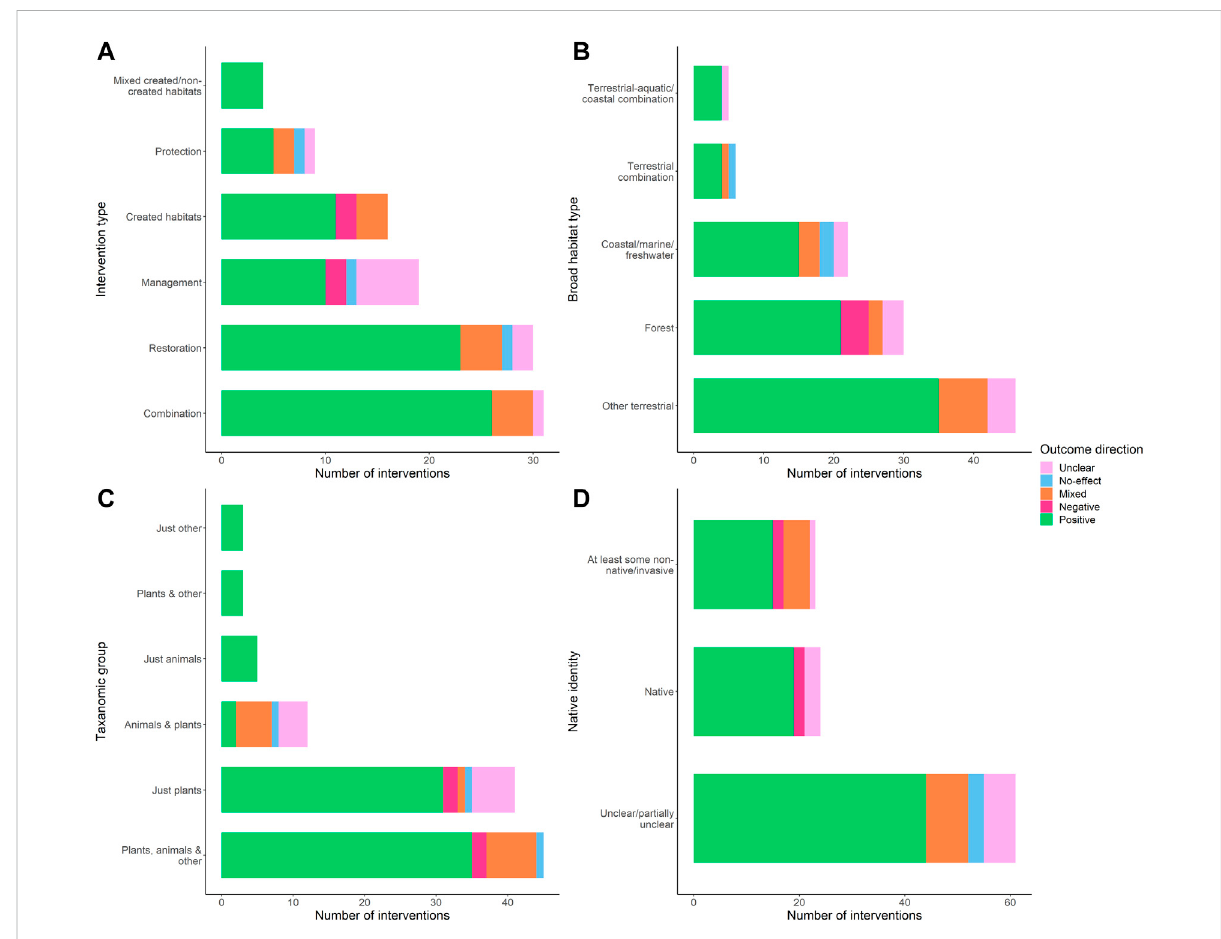
FIGURE 5 Ecosystem health outcomes of interventions split by intervention type (A) , habitat type (B) , taxonomic group (C) , and native identity (D) . Native identity refersto whether thespeciesstudied in anecosystem health outcomewereall native,included atleastsomenon-nativeor invasive species, or whether this was